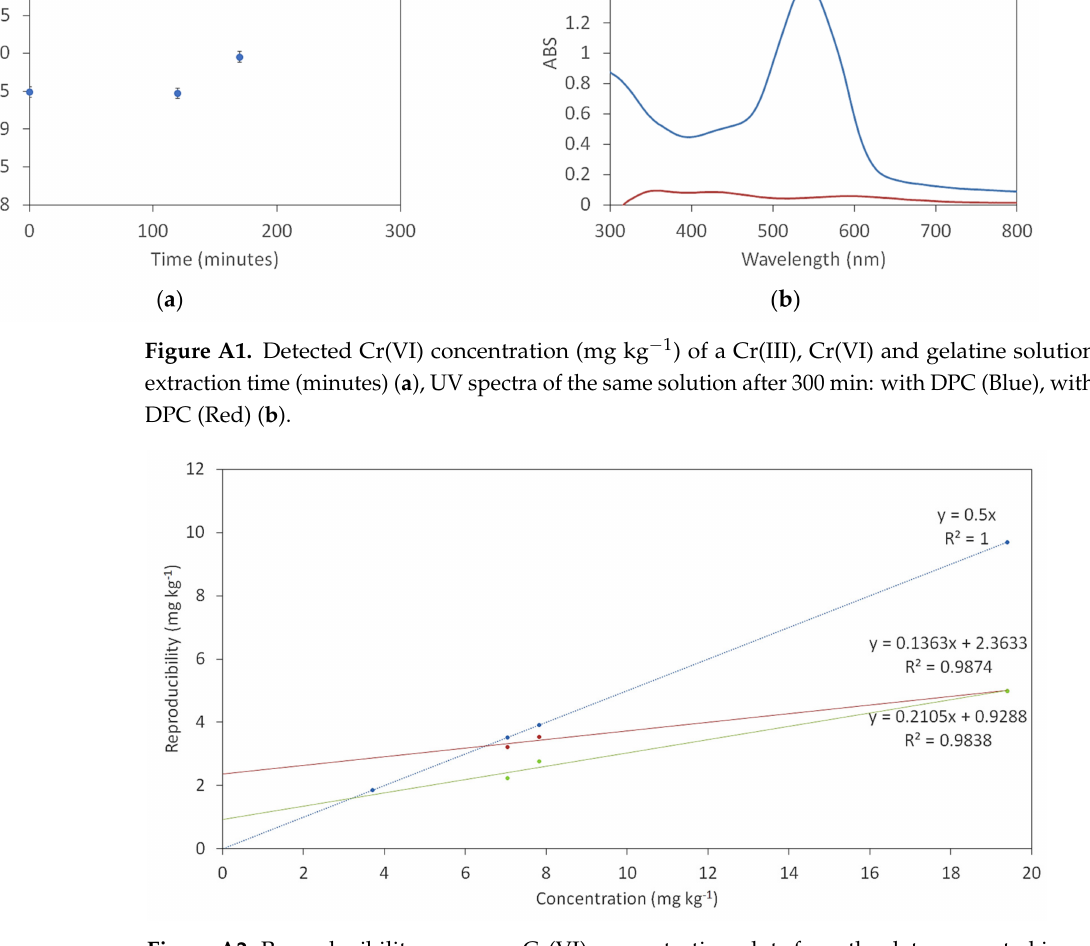
Figure A2. Reproducibility vs. mean Cr(VI) concentration plots from the data presented in annex B of BS EN ISO 17075:1-2017 [11]. Raw data are as presented in Tables B.1 and B.2 (red), and chart points are as shown in Figure B.1 (green), with 50% error calibration (blue). Trendlines are linear regressions of the data points